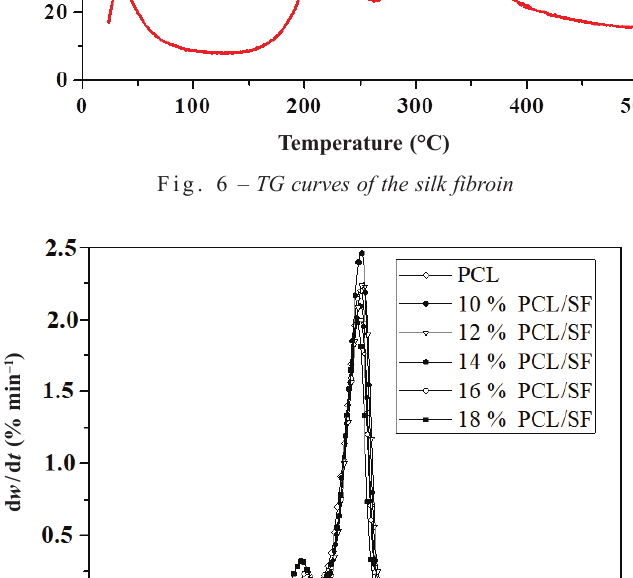
Fig. 6 – TG curves of the silk fibroin